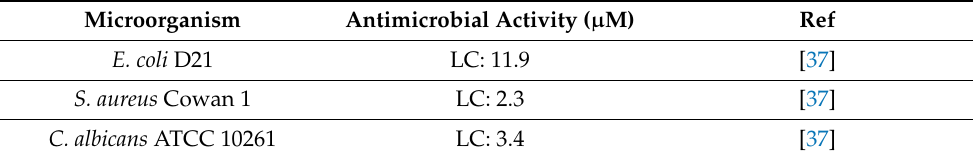
Table 3. Antimicrobial activity against selected microorganisms of temporin A. Microorganism